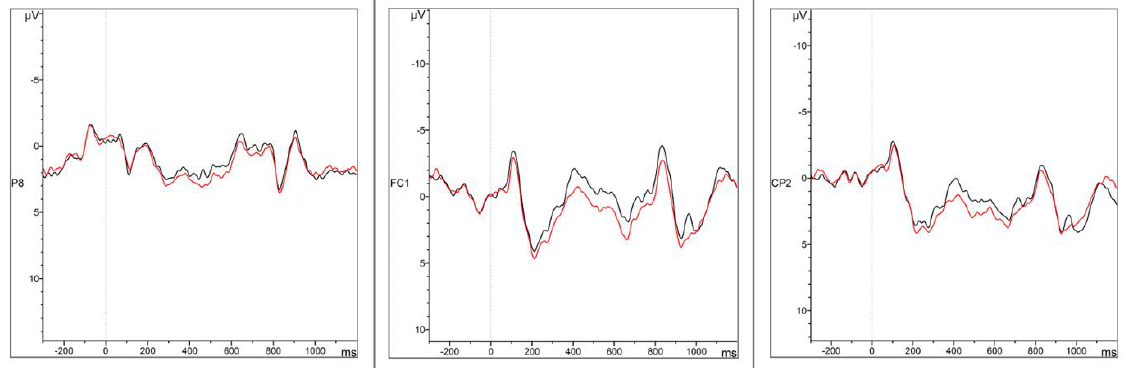
Figure 5. Grand Average ERP waveforms for the grammatical ( black ) and adjective position ( red ) conditions in Mini-Latin at electrodes P8, FC1 and CP2.